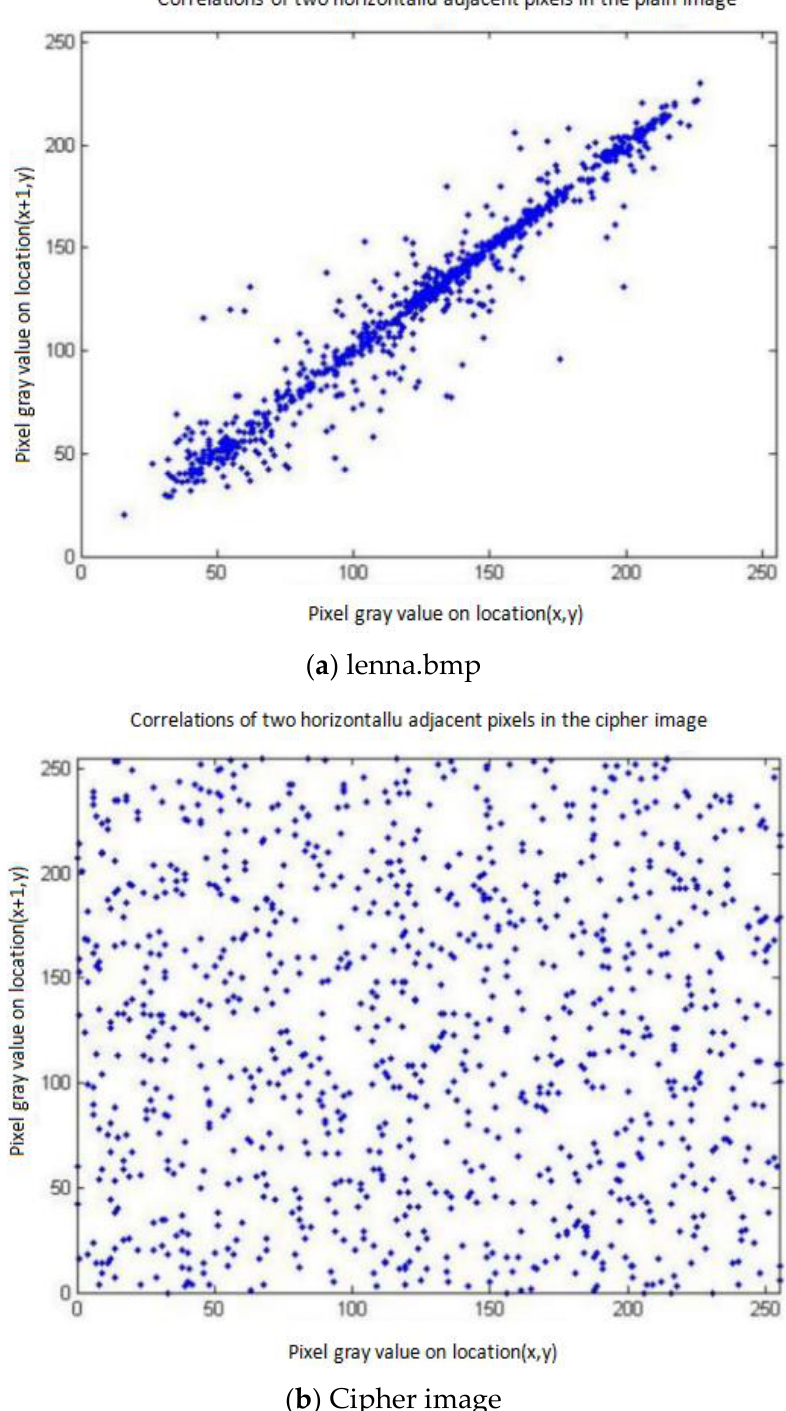
Figure 6. Correlation coefficient analysis.